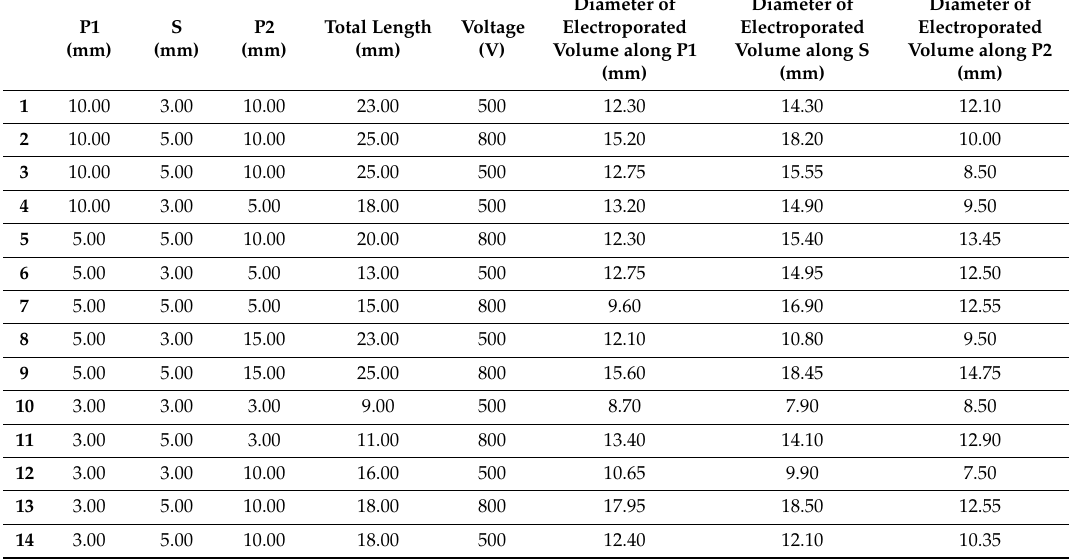
Table 2. Tests performed during the pre-clinical study on a vegetable model. Total length: P1 + S + P2. The maximum diameters of the electroporated volume around the poles, observed 24 h after the treatment, are also